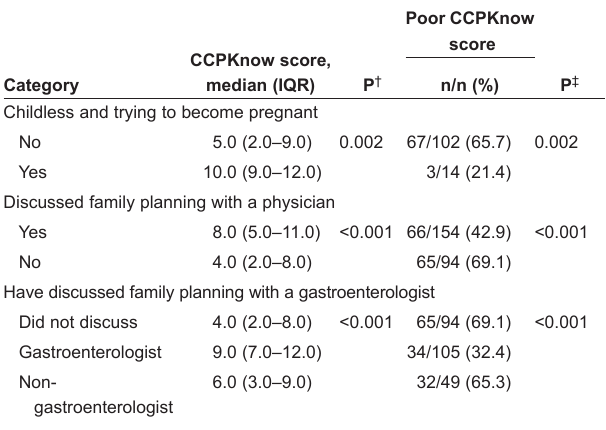
Description of inflammatory bowel disease (IBD)-specific reproductive knowledge levels in 248 female IBD